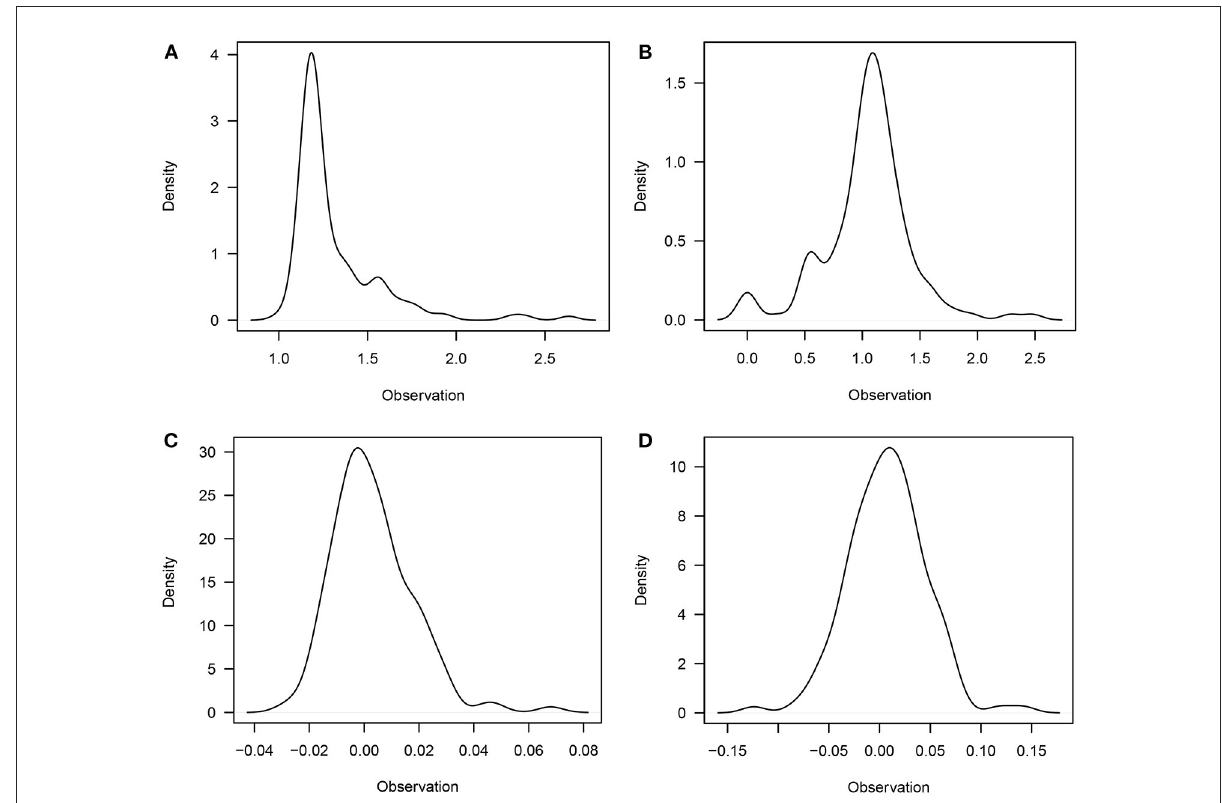
FIGURE1 The distribution of litter size at birth (A) ; litter size at weaning (B) ; PBVs for litter size at birth (C) ; and PBVs for litter size at weaning (D)